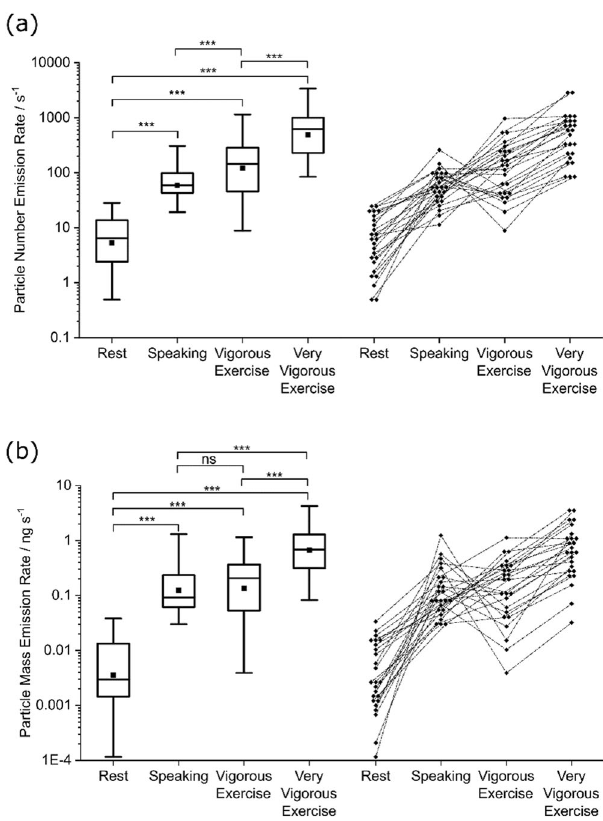
Fig. 4 Aerosol number and mass emission rates for breathing at rest and during exercise, and while speaking. Box and whisker plots (left) and corresponding data (right) showing particle number emission rates ( a ) and mass emission rates ( b ) for the same series of activities (breathing at rest, during vigorous exercise, during very vigorous exercise and speaking at 70 – 80 dBA) across n = 25 participants. Boxes indicate mean, median and IQR, whiskers indicate the range (data within 1.5 IQR), *** indicates p < 0.001, not signi fi cant (ns). ns not signi fi cant, dBA A-weighted decibels; IQR interquartile